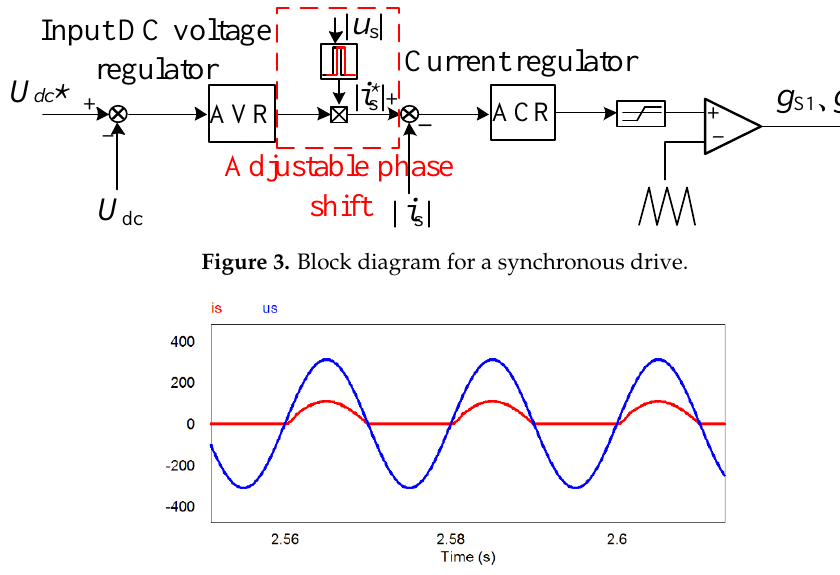
Figure 4. Simulation current waveform on the alternating current (AC) side based on a synchronous drive without an absolute value module.